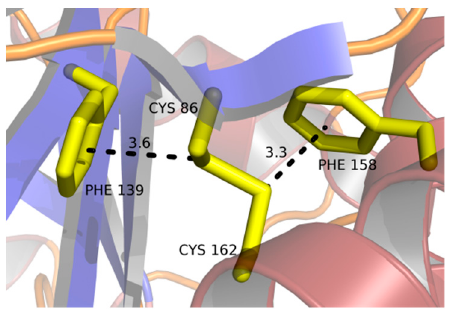
Figure 6. Disulfide bridge between Cys86 and Cys162 which includes S– π interactions with aromatic rings. Distances are indicated in angstroms.